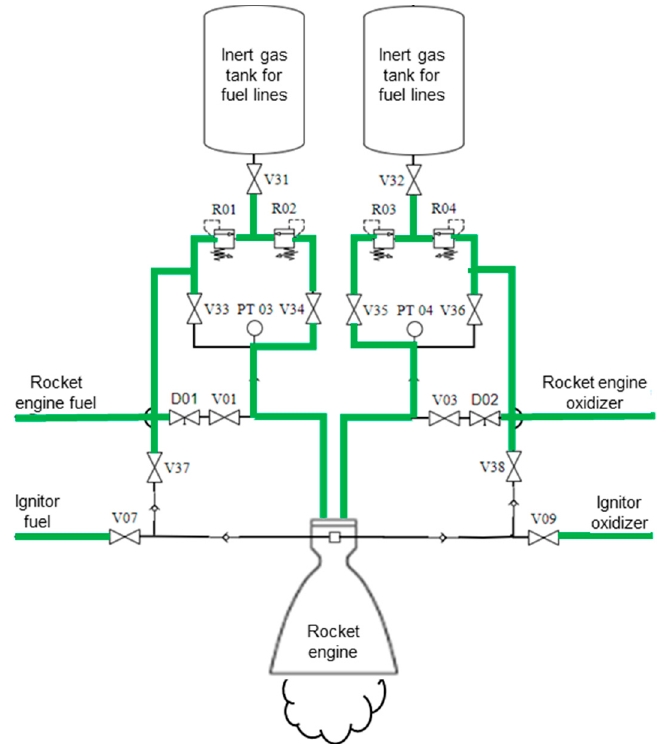
Figure 33. Algorithm’s 13th step diagram.